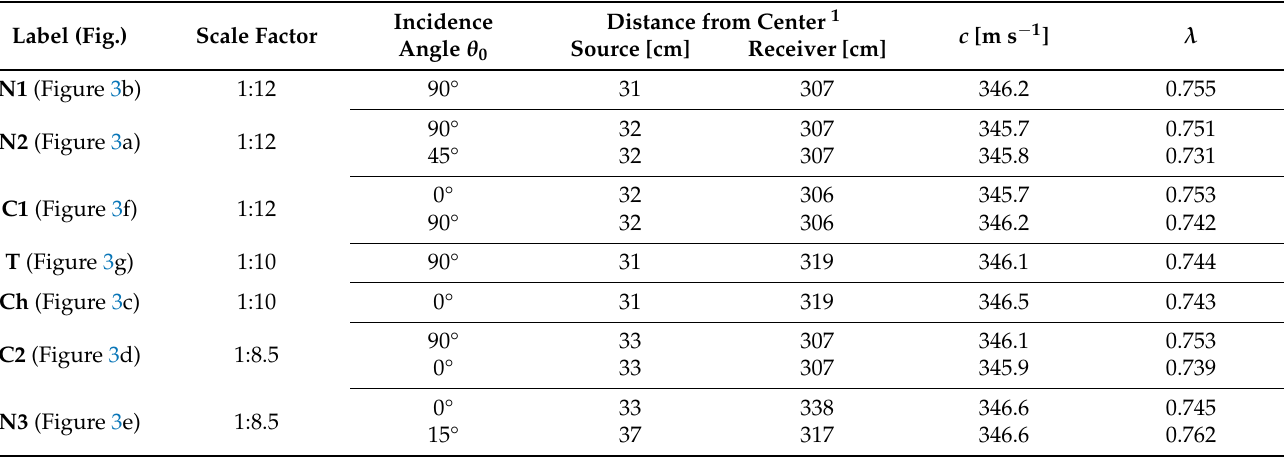
Table 1. Experimental set-ups and parameters for the measurements on scale models with the Courant number λ used in each corresponding